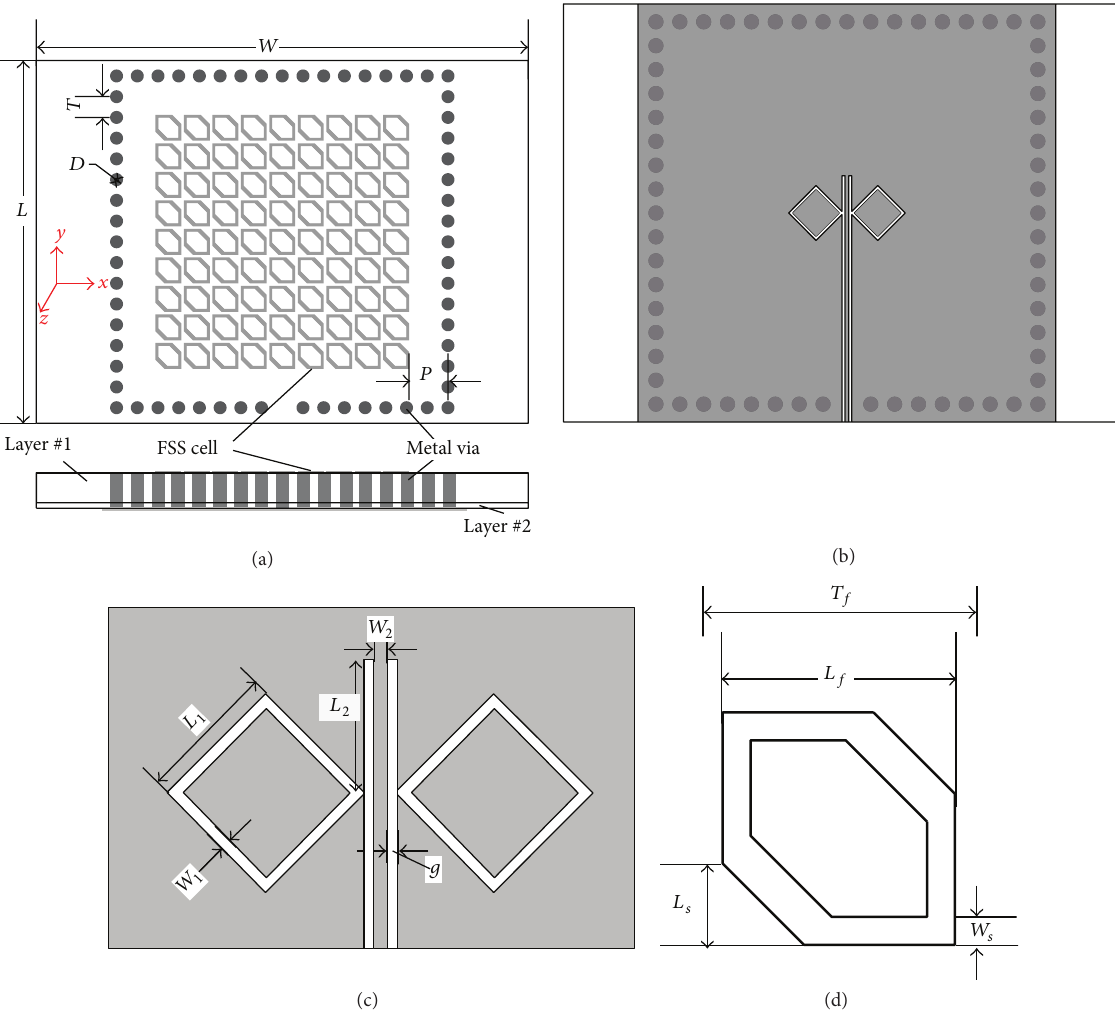
Figure 1: Antenna structure. (a) Front and side view, (b) back view, (c) detailed structure of the dual rhombic slot loop, and (d) detailed structure of the PRS